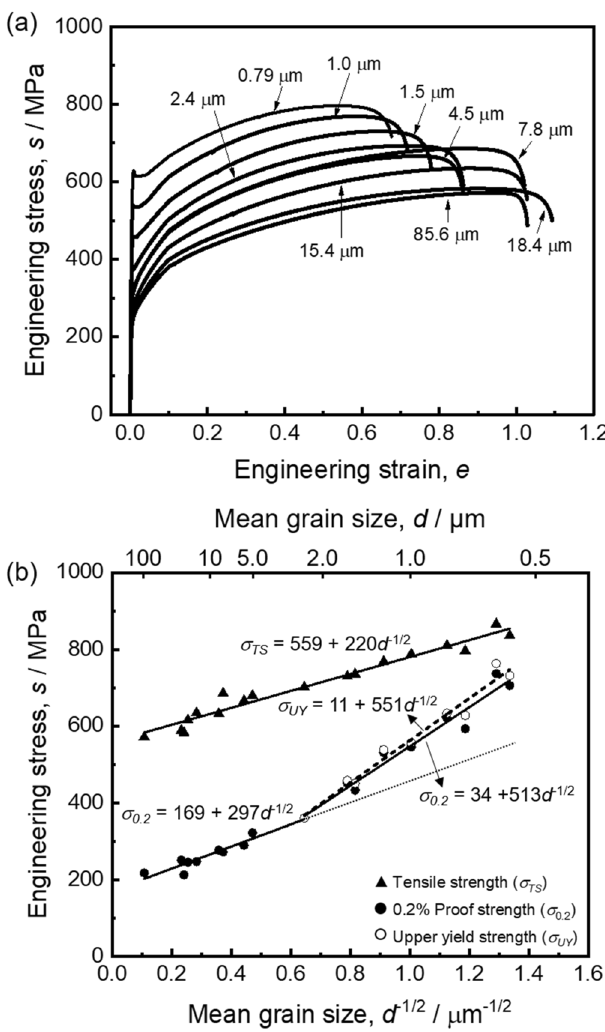
Figure 2. ( a ) Engineering stress–strain curves of the Fe-31Mn-3Al-3Si specimens with various recrystallized grain sizes. The mean grain sizes are indicated in the figure. ( b ) Hall–Petch plots of the yield strength and tensile strength as a function of minus square of the mean grain